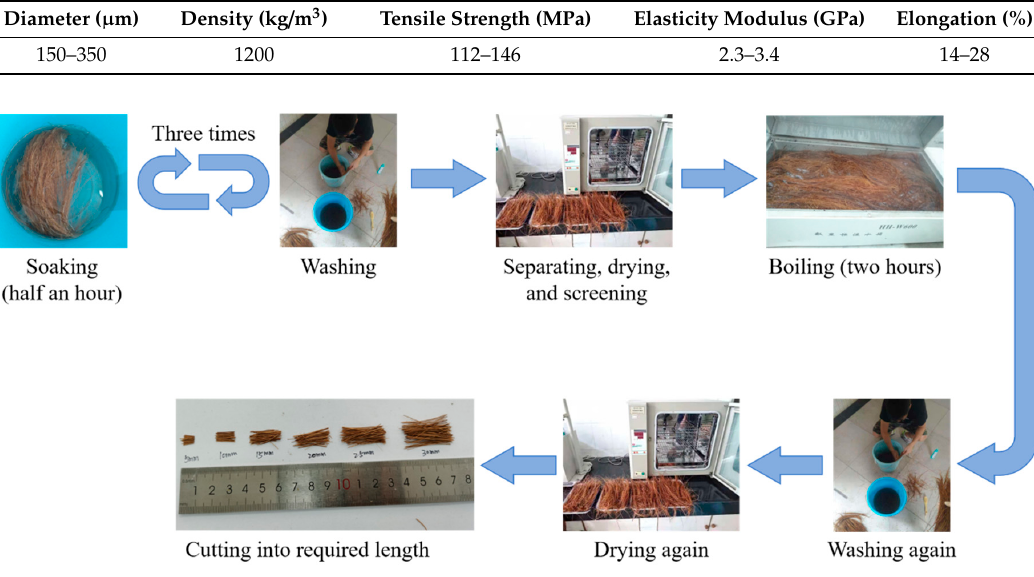
Figure 3. Treating process of CF. Table 5. Physical properties of coir fiber (CF).